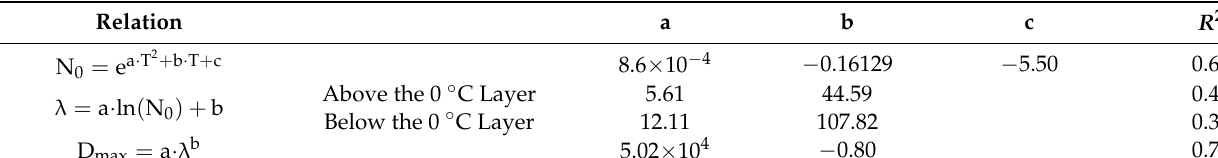
Table 4. The fitting of relationships between spectral parameters.